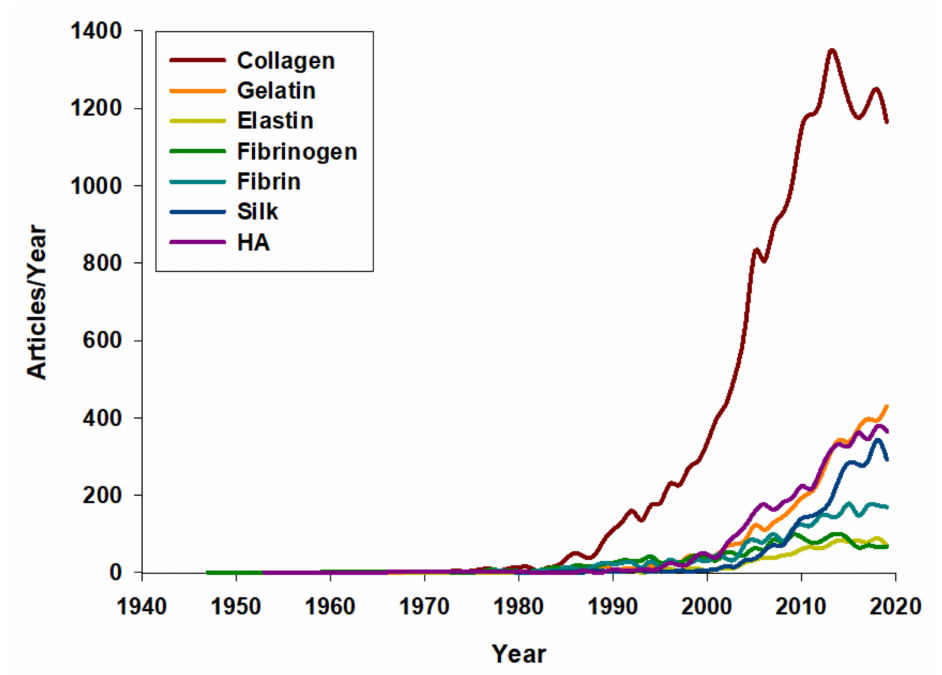
Figure 2. Scientific articles published referring to “X biomaterial” from 1940 to 2020. The number of articles published in each year, from 1940 to 2020, was identified by searching the terms referred in the legend in the PubMed database (https: // pubmed.ncbi.nlm.nih.gov / ), queried on 7 October